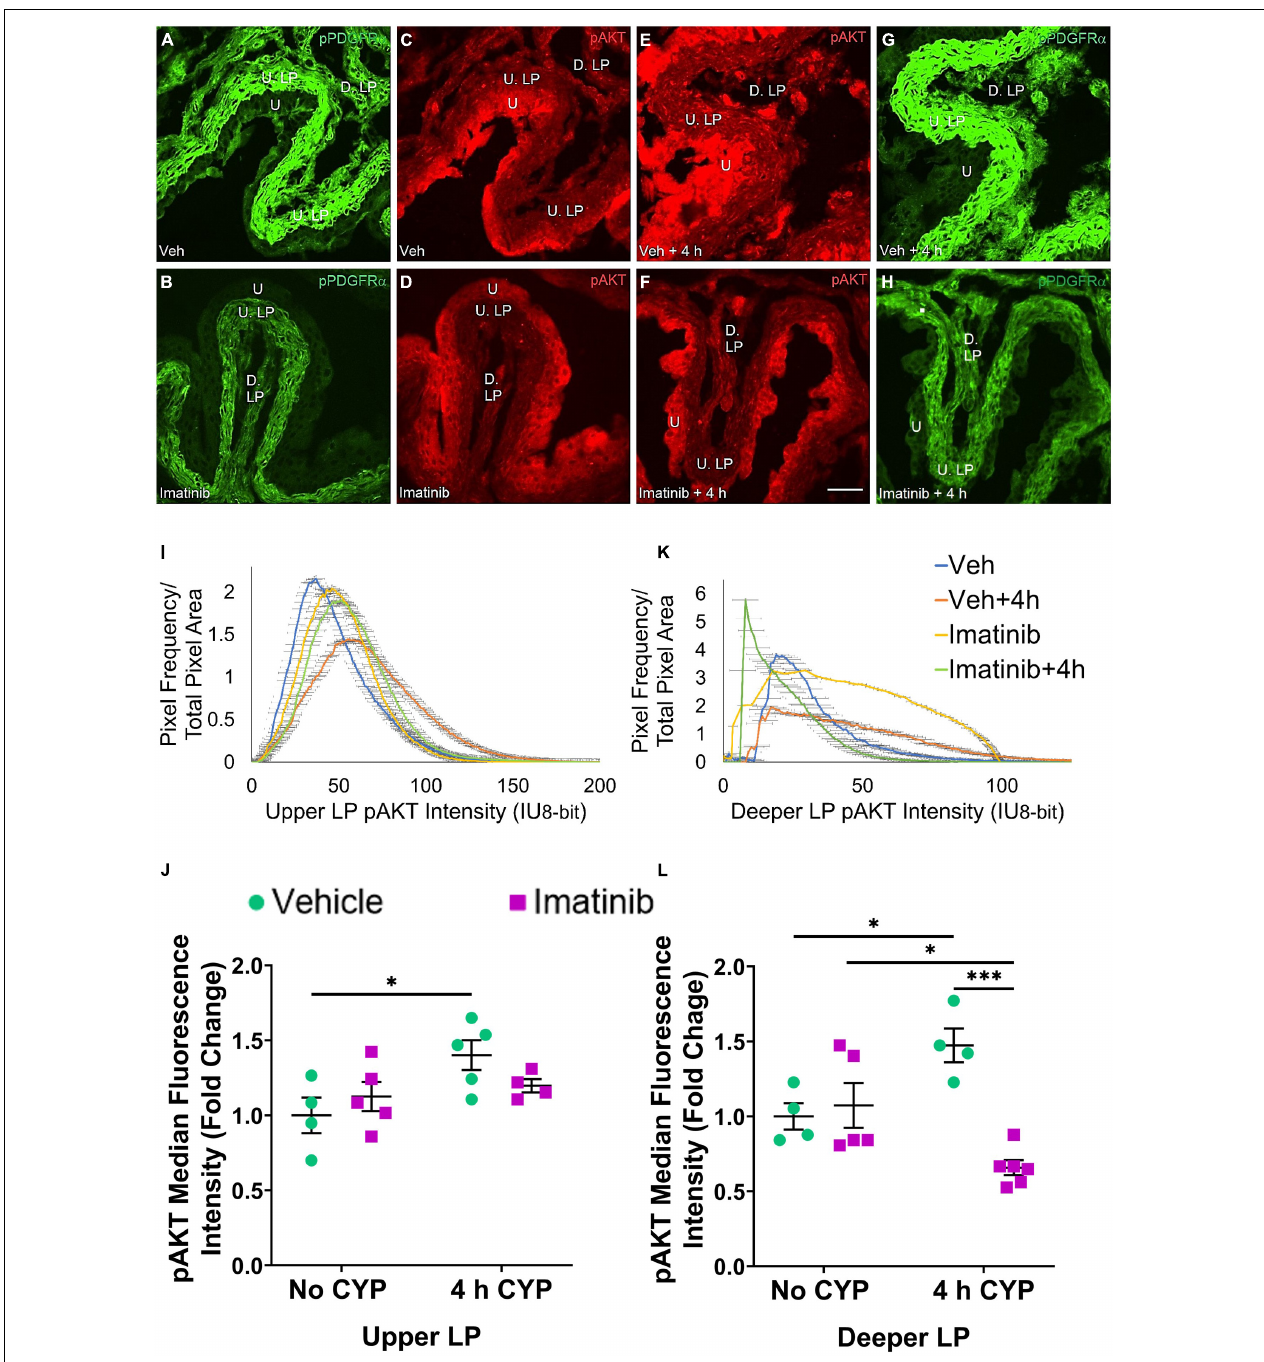
FIGURE 8 | Oral gavage of imatinib mesylate reduces pAKT expression in the deeper lamina propria (D. LP), but not upper lamina propria (U. LP), in an acute (4 h) cyclophosphamide (CYP)-induced cystitis female mouse model. Representative (A–H) images, (I) upper LP and (K) deeper LP fluorescence intensity curves of pAKT immunoreactivity (CY3, red) in the urinary bladder (10 µ m sections) in female mice with (E) acute (4 h) cyclophosphamide (CYP)-induced cystitis (200 mg/kg, i.p.) and (C,D) controls (no CYP), (F) pre-treated with imatinib mesylate via oral gavage (250 mg/kg, 5 days, 1X/day). (A,B,G,H) Bladder tissue was co-stained for pPDGFR α (FITC, green), and the corresponding images are displayed to provide orientation. 4 h CYP treatment significantly ( p ≤ 0.05) increased pAKT expression in the (J) U. LP (1.4-fold) and the (L) D. LP (1.2-fold), compared to vehicle controls. Imatinib prevention significantly ( p ≤ 0.001) reduced pAKT expression in the (L) D. LP (2.2-fold), but not the (J) U. LP in female mice with 4 h CYP-induced cystitis. Raw IHC values (intensity units, 8-bit) are presented as fold change values ± SEM with respect to the control group (vehicle, no CYP). n = 4–6. * p ≤ 0.05; ** p ≤ 0.01; *** p ≤ 0.001; **** p ≤ 0.0001 by two-way ANOVA with Tukey’s multiple comparisons test. Tissues were processed simultaneously. Microscope and camera settings were kept constant across all groups. Fluorescence intensity was measured using Volumetry image analysis software (VolumetryG9a, Grant Hennig). 10 µ m sections. Scale bar = 50 µ m. U, urothelium; U. LP, upper lamina propria; D. LP, deeper lamina propria; IU, intensity